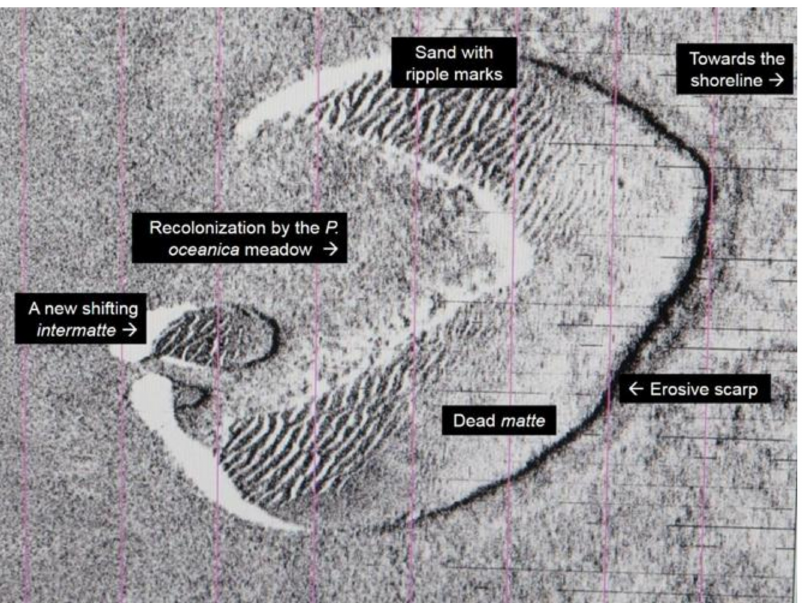
Figure 3. Shifting intermattes . 30 m depth. U Caterraghju (Aleria, eastern coast of Corsica). Side- scan sonar image. Mission Coralcorse (G é rard Pergent and Ifremer). Photo © Charles-François